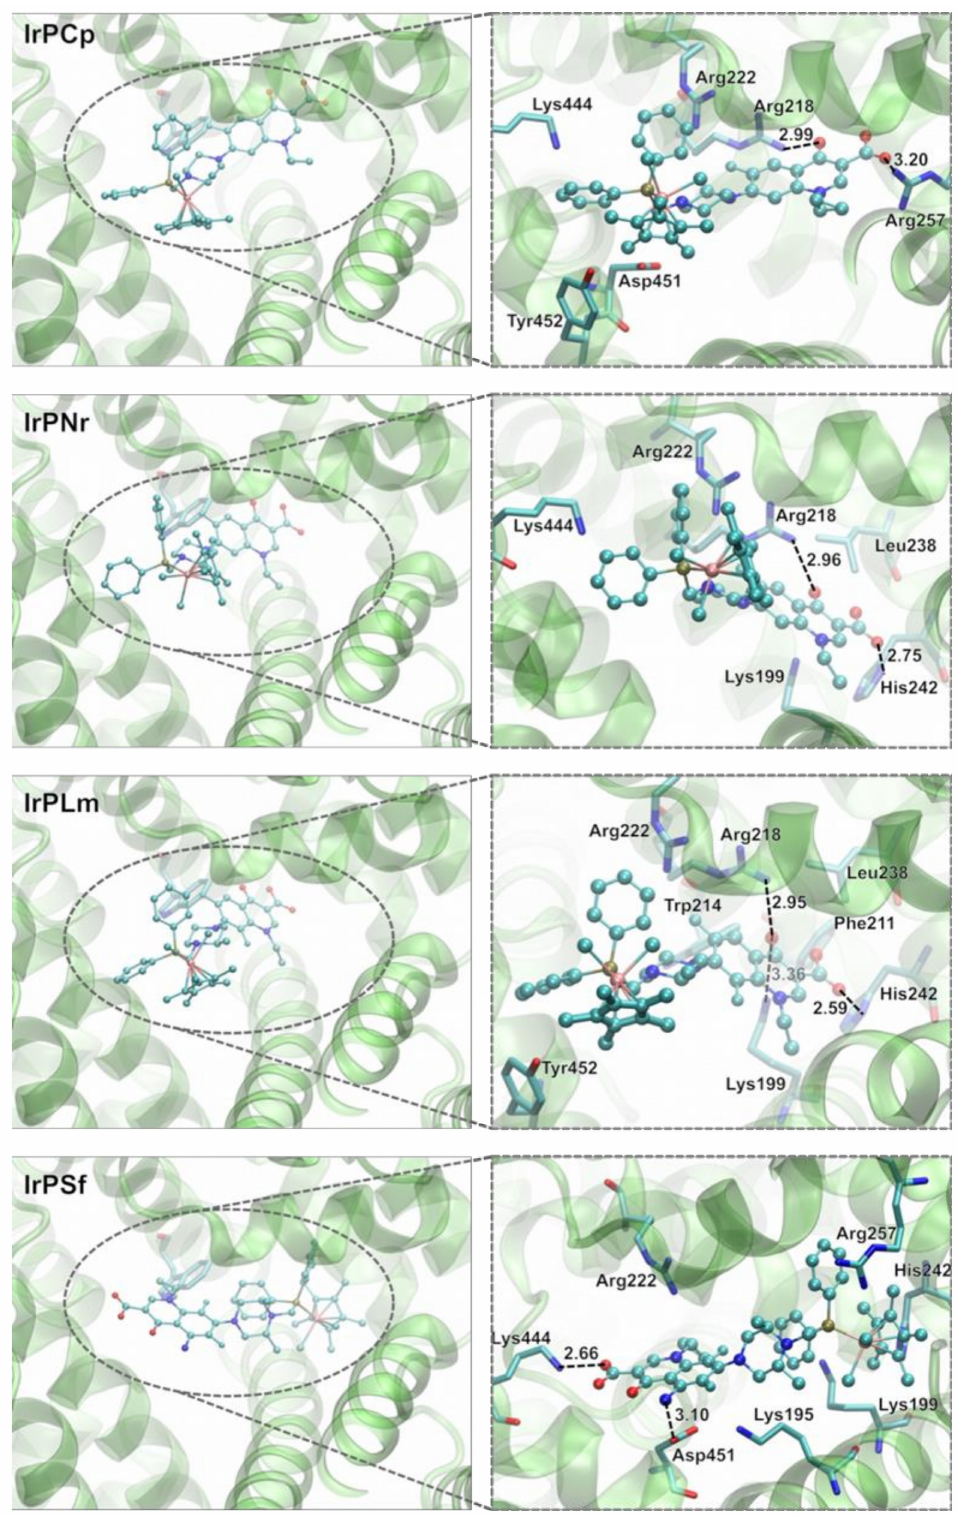
Figure 8. Binding mode of HSA-phosphinoiridium(III) complexes. The docked compounds are shown in ball-and-stick representation. Trp214 residue is shown in stick representation in the panels on the left side. In the right side panels are all the HSA residues within 3 Å of the metal complexes. The selected distances are given in Å. Hydrogen atoms are not shown for